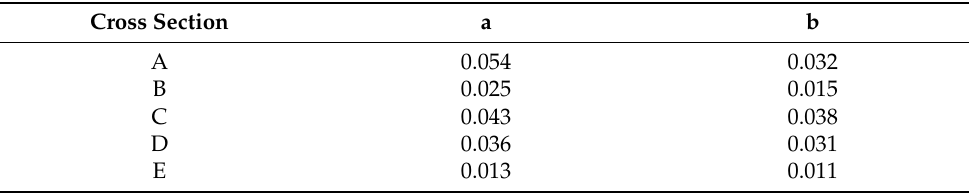
Table 1. Empirical coefficients a and b for each type of cross section.